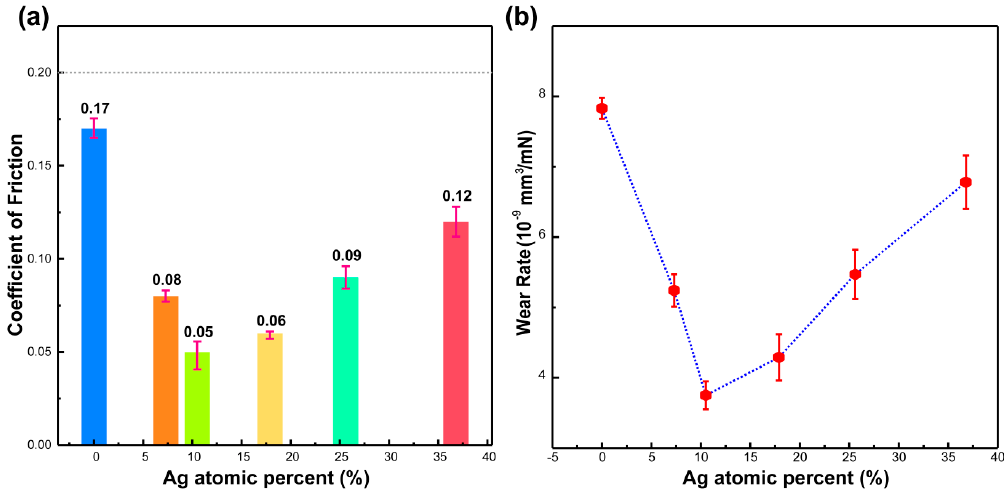
Figure 5. ( a ) Friction coefficient and ( b ) Wear rate of Ag-DLC films as a function of the Ag